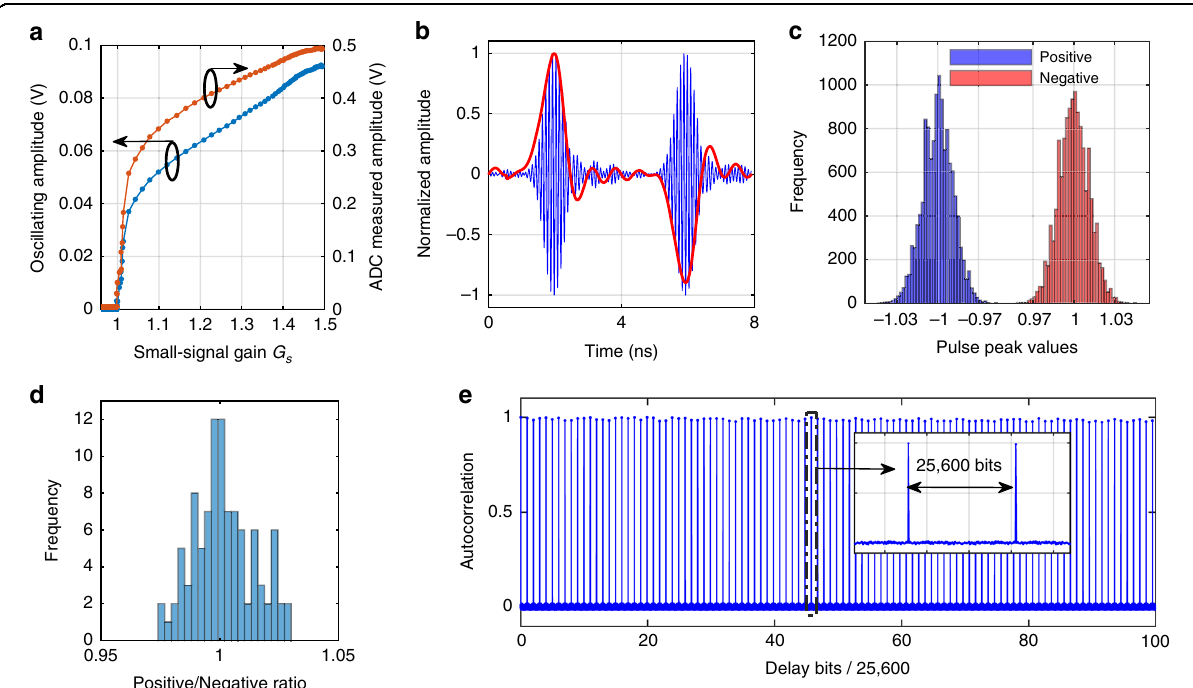
Fig. 2 The experimental results of non-interaction oscillation. a The amplitudes of the OEPO output and the ADC measurement as functions of the cavity small-signal gain. b The oscillating microwave pulses centered at 10 GHz (blue curve), along with the corresponding demodulated baseband waveforms (red curve). c The histogram shows the frequency of normalized peaks of the demodulated baseband pulses. The obvious distinction between positive and negative baseband pulses suggests that microwave pulses oscillate with a relative phase of either 0 or π . This binary phase oscillation is used to represent the Ising spin. d The histogram shows the frequency of the ratio of positive pulses to negative pulses in 100 tests. Each test restarted from the noise state to the stable state. e The autocorrelation of the pulse peaks. Inset: zoomed-in view of the area of the red dashed rectangle. The peaks repeat each 25,600-bit delay, indicating that the optoelectronic cavity stores 25,600 microwave pulses. The fl at peaks